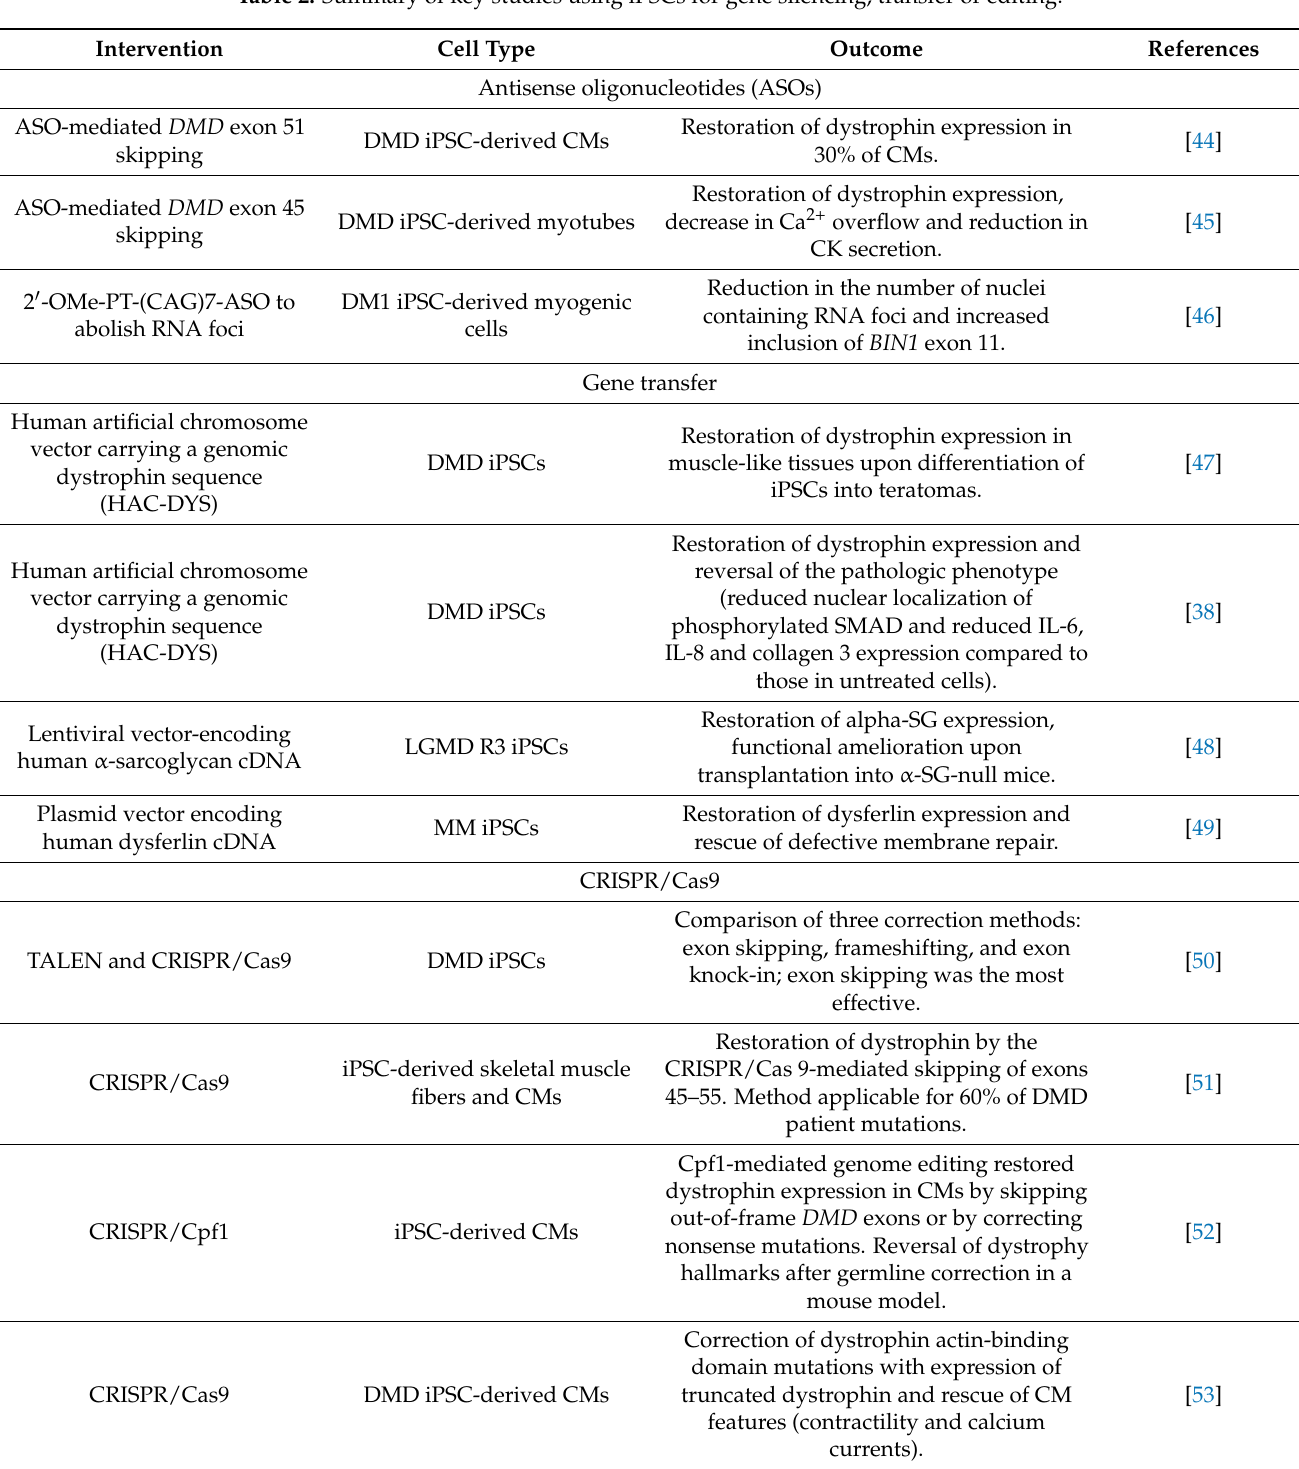
Table 2. Summary of key studies using iPSCs for gene silencing, transfer or